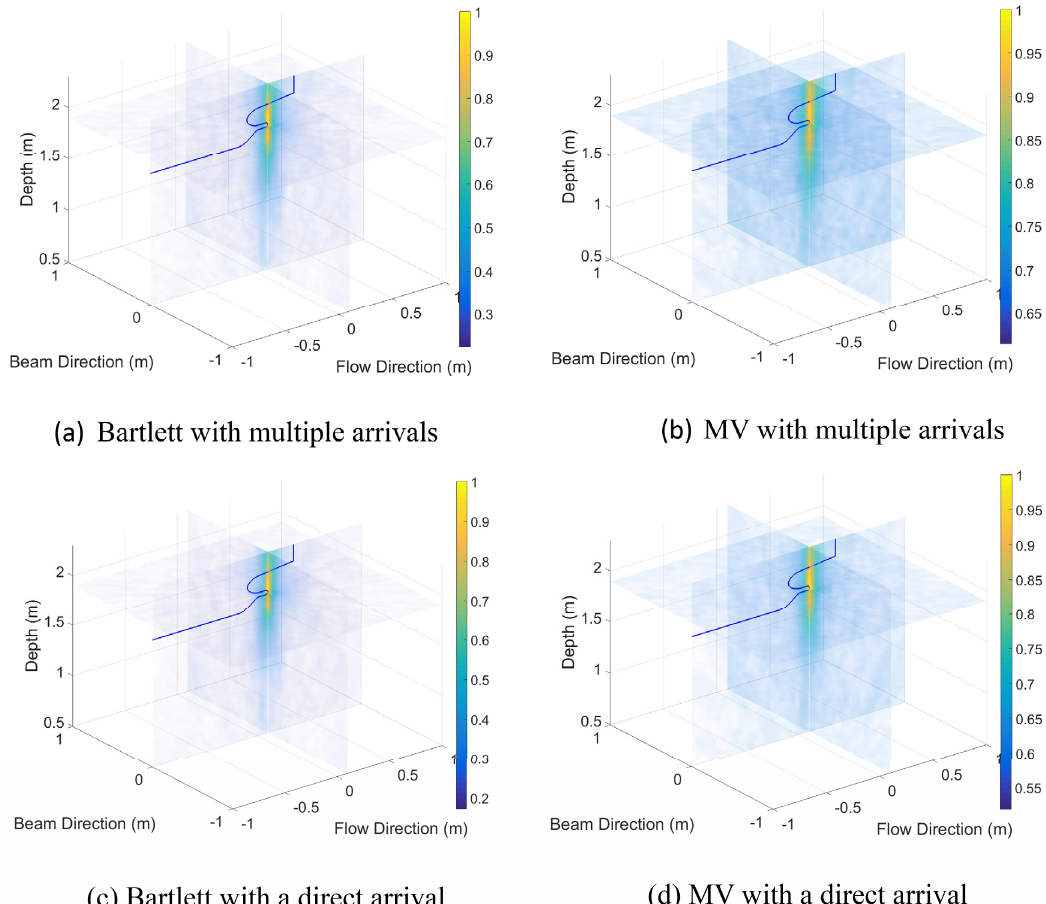
Figure 6. Configuration of the virtual source experiment ( a ) and measured sound pressure level ( b ), which is averaged for the 45-channel hydrophones. (SPL: sound pressure level, Freq.: frequency).